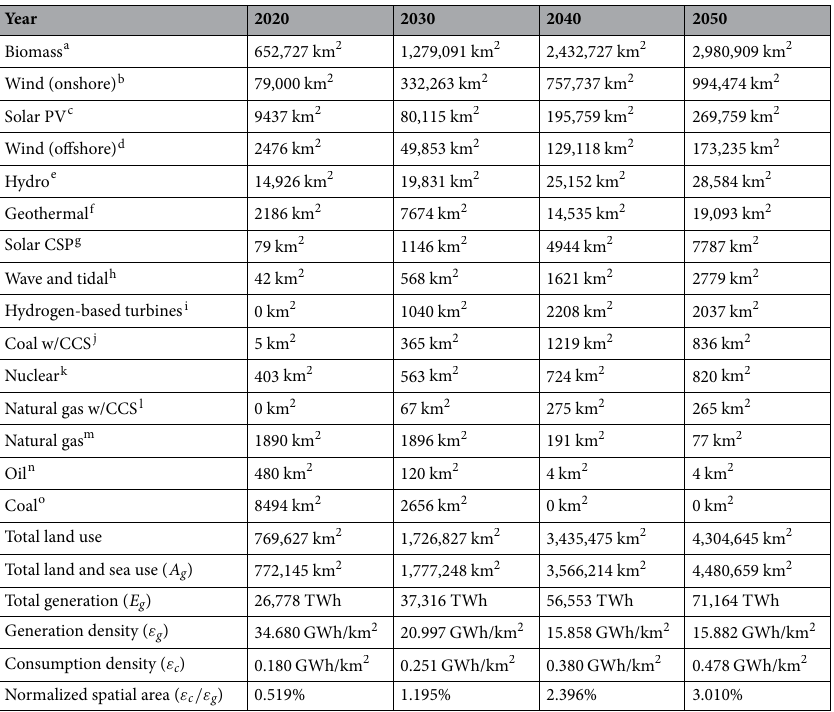
Table 20. Projected land and sea use requirements under the NZE 2050 scenario in Table 19, where the required area ( A g ) is estimated for individual power sources based on Eq. (6). This is based on a mean energy density assumption, with values retrieved from the data summarized in Table 16. The remaining values are obtained from other sources specified in the footnote. a Biomass 3 : 0.0011 TWh/km 2 . b Wind (onshore):